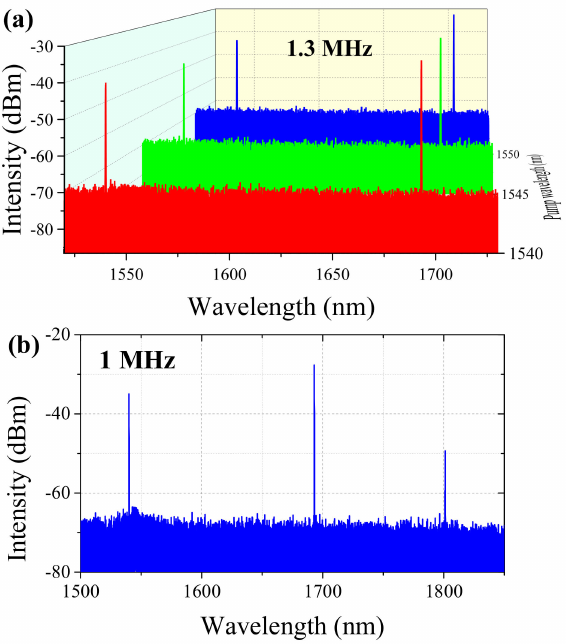
Figure 2. ( a ) Output spectra of different pump wavelengths at the maximum pump power when the repetition frequency is 1.3 MHz; ( b ) Output spectrum of 1540 nm pump wavelength at the maximum pump power when the repetition frequency is 1